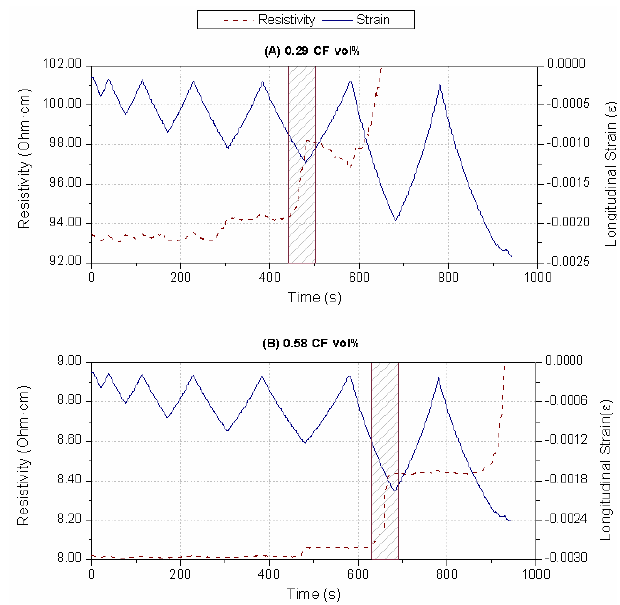
Figure 4. Fractional change of resistance and longitudinal strain versus time until materials failure for different CF additions: ( A ) 0.29 CF vol %; ( B ) 0.58 CF vol %. The shaded area corresponds to the damage sensing mechanism